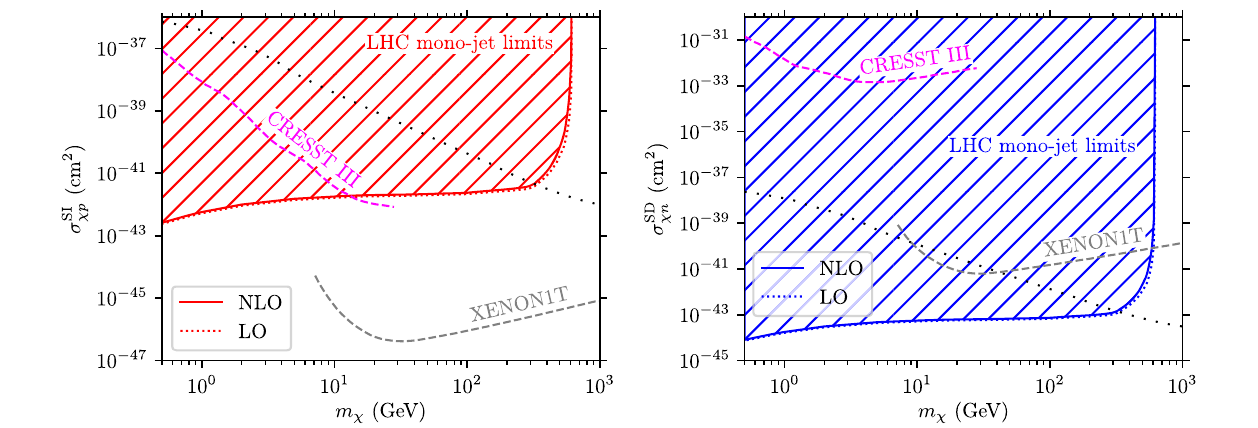
Fig. 8 Exclusion limits (hatched areas) for σ SI p (left) and σ SD n (right), extracted from ATLAS [33] data at LO and NLO-QCD, and from the CRESST[30]andXENON[31,32]experimentsforthe t -channelmodel